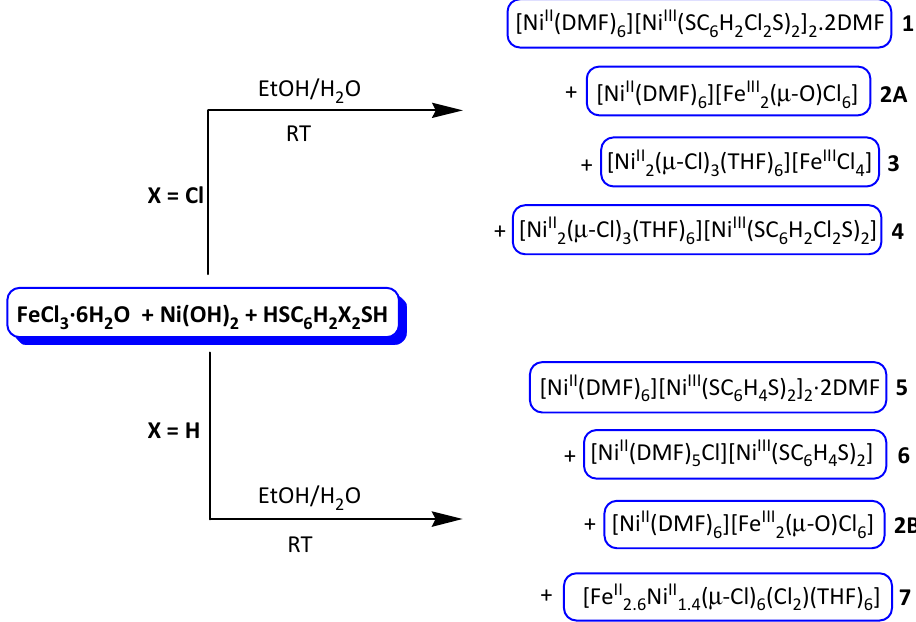
Scheme 1. Schematic representation of the reactions carried out to isolate compounds 1 – 7 .